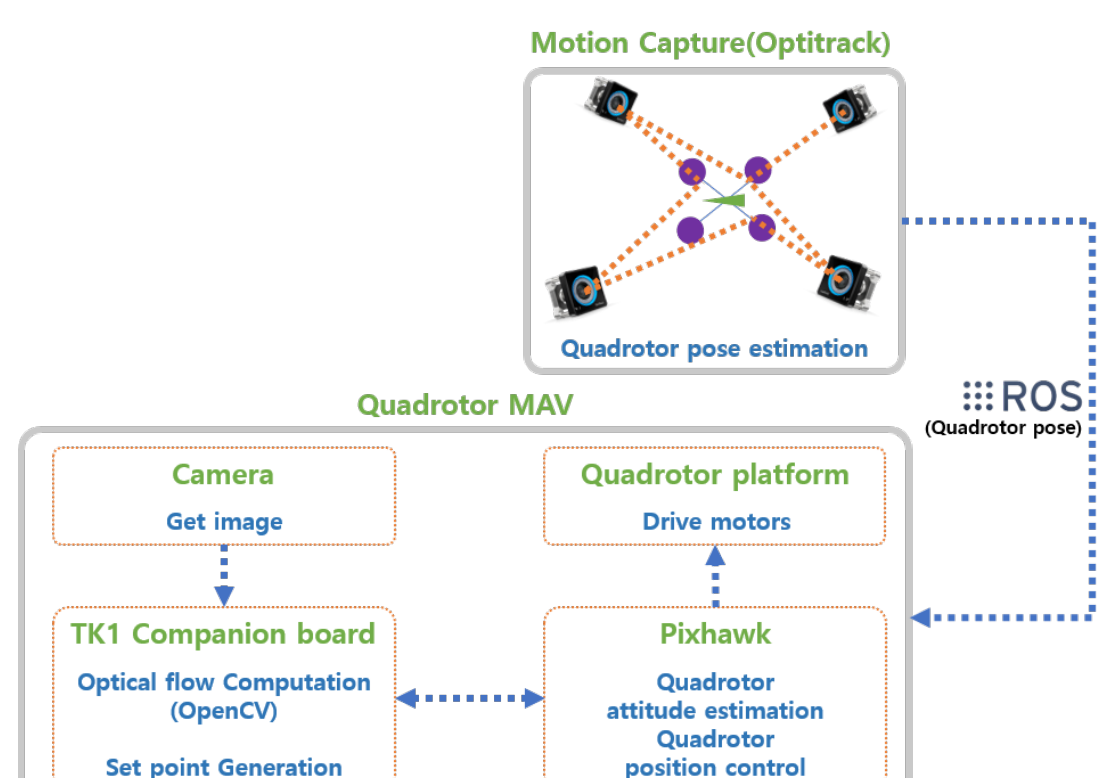
Figure 15. Quadrotor MAV setup and indoor localization system for obstacle avoidance